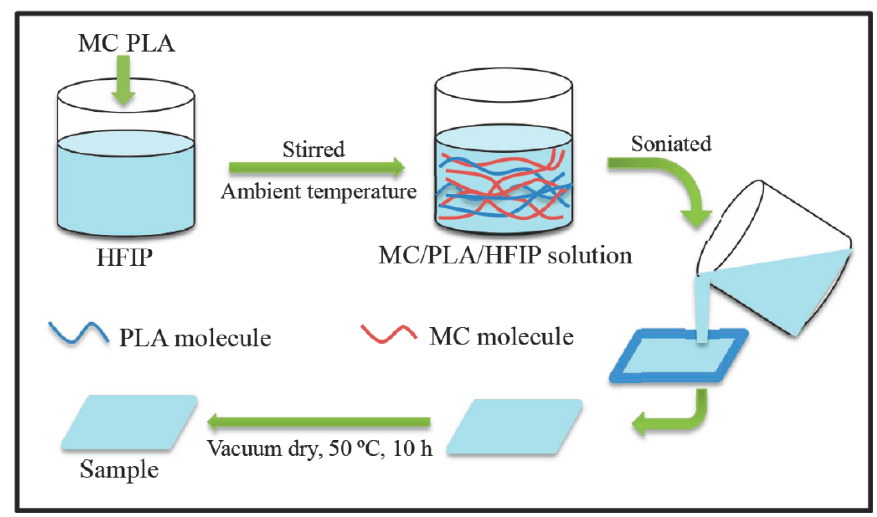
Figure 2. Process flow chart of the sample preparation.